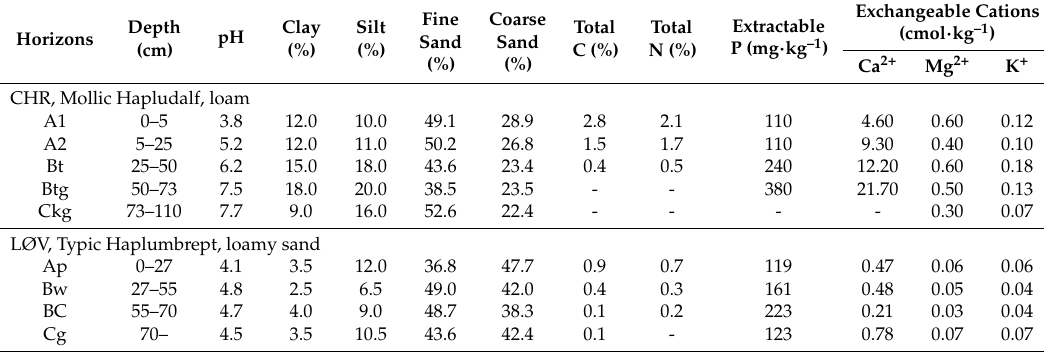
Table 1. Soil properties at Christianssæde (CHR) and Løvenholm (Løv) sites (adapted from [18]).